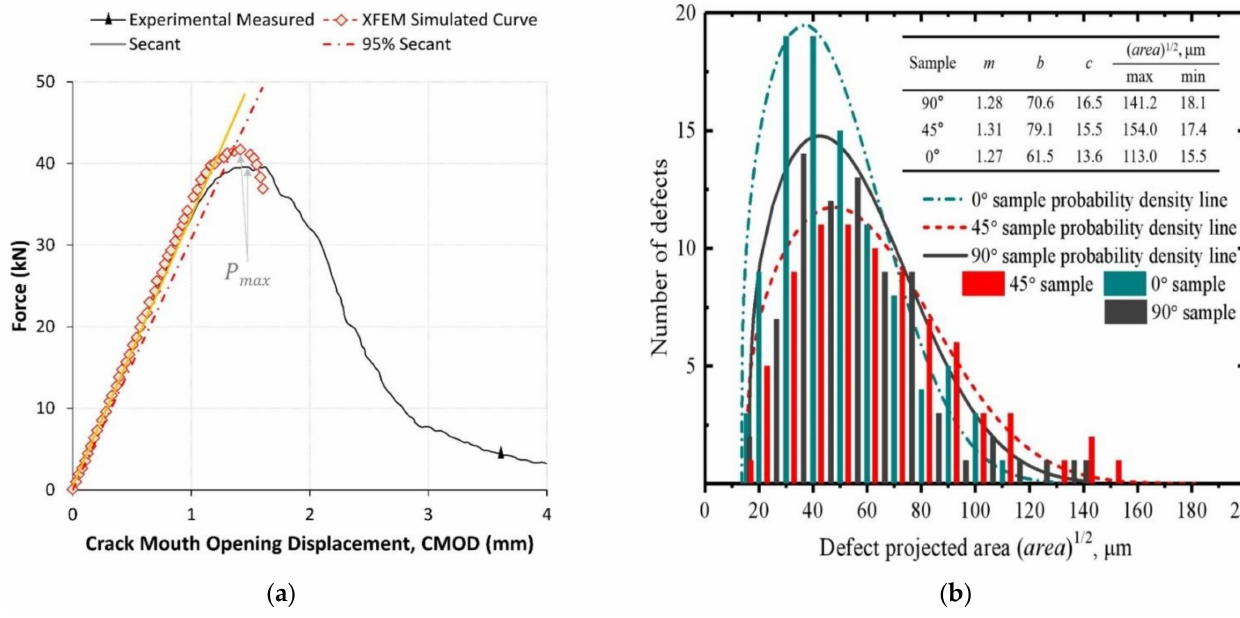
Figure 27. ( a ) Experimental and simulated Force vs. COD curve for Ti6Al4V alloy. Reprinted with permission from ref. [84]. 2020, John Wiley, ( b ) Weibull probability density lines and parameters of the SLM Ti6Al4V specimen defect sizes obtained from RBF sample fracture surfaces. Reprinted with permission from ref. [67]. 2021,